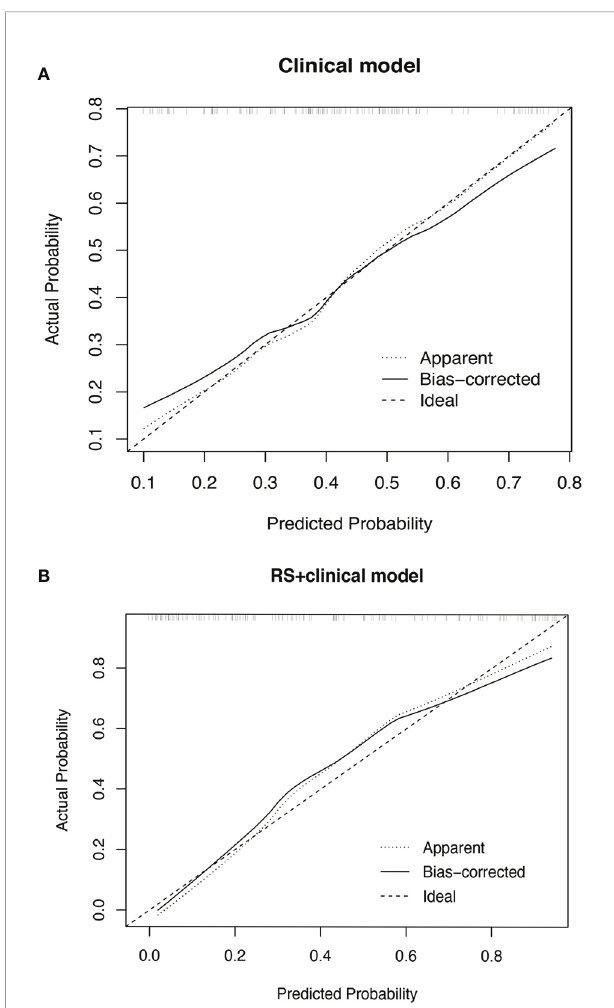
FIGURE 2 | Calibration plot of the clinical model (A) and RS+clinical model (B) . The calibration curves of clinical model and RS+clinical model showing the difference between the predicted probability of pCR and the observed (actual) probability. The “ Ideal ” line represents the perfect prediction as the predicted probabilities equal to the observed probabilities. The “ Apparent ” curve is the calibration of the primary cohort. The “ Bias-corrected ” curve was the calibration created by internal validation of 2000-replicate bootstrap on the primary cohort.